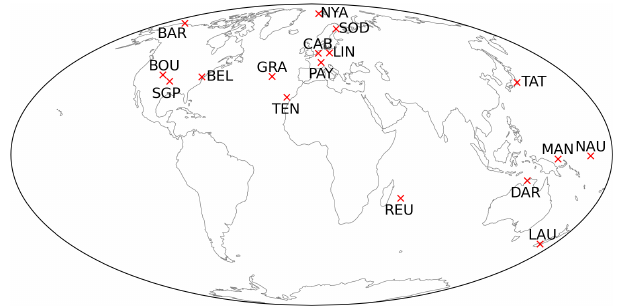
Figure B4. Location of GRUAN stations considered in this study. For station names and further details see Table B1.